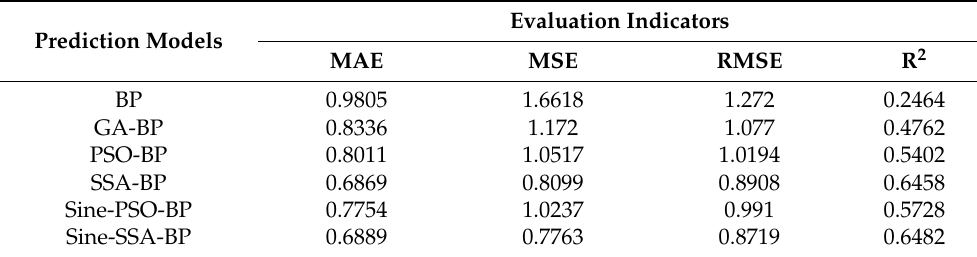
Table 5. Comparison of evaluation indicators among prediction models.